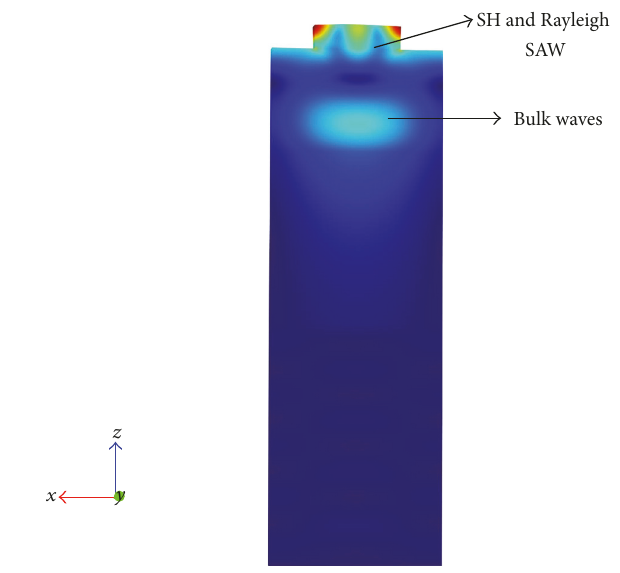
Figure1:Quasi-3DperiodicFEMmodelusedinthesimulation(not to scale).